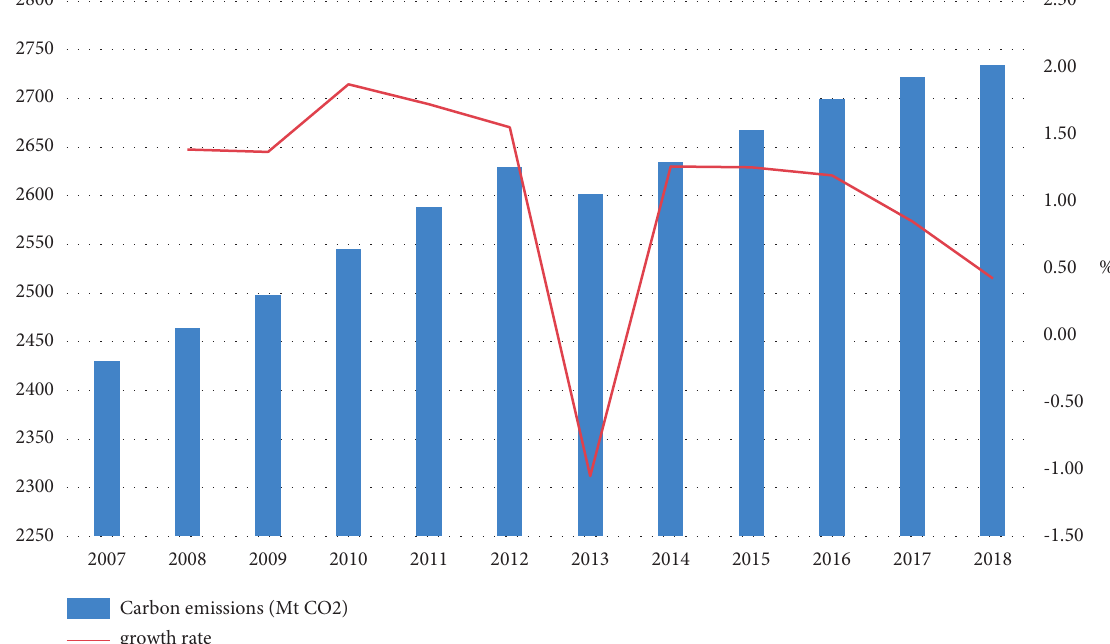
Figure 1: Carbon emissions and growth rate of China’s transportation industry from 2007 to